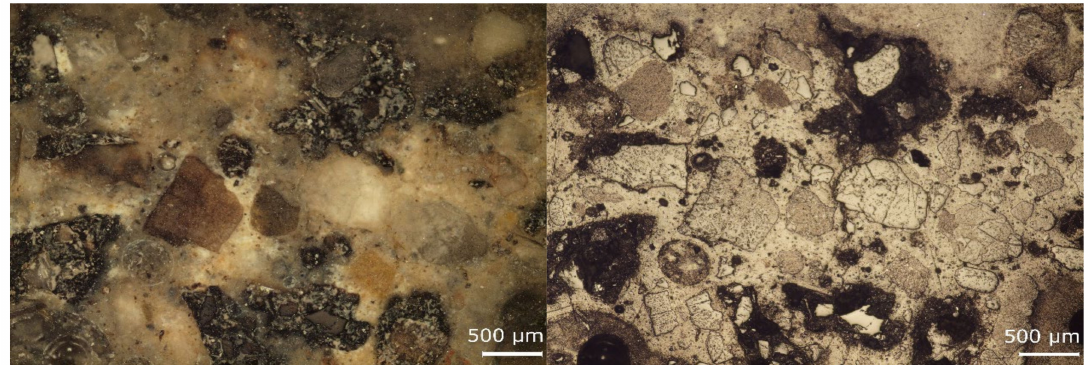
Figure 11. Microscopic images of concrete sample RA-C 50 observed under unpolarized ( left ) and polarized ( right )